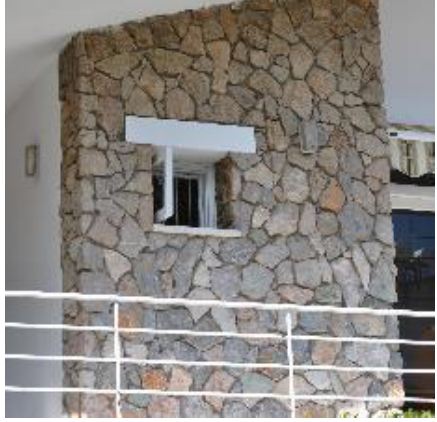
Figure 24. Details of Efrus House (Image by Author,